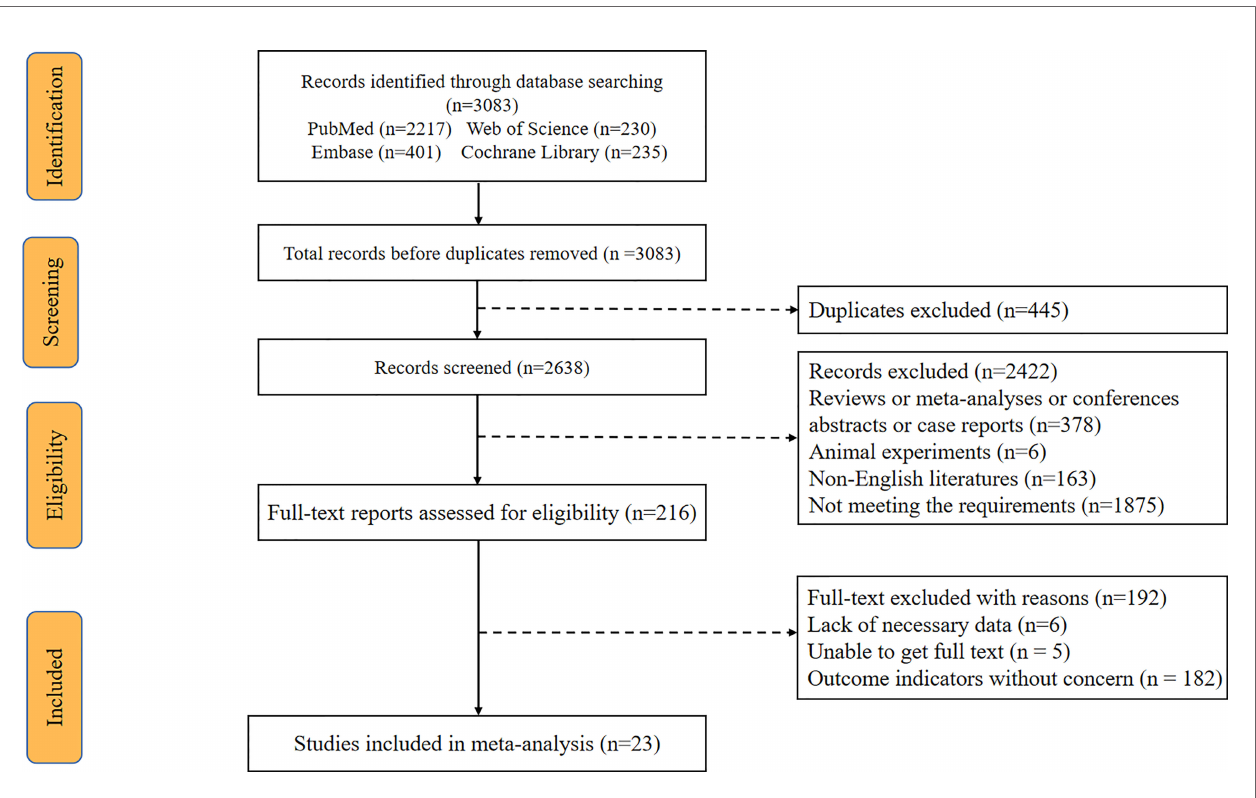
FIGURE 1 | Flow diagram of the study selection